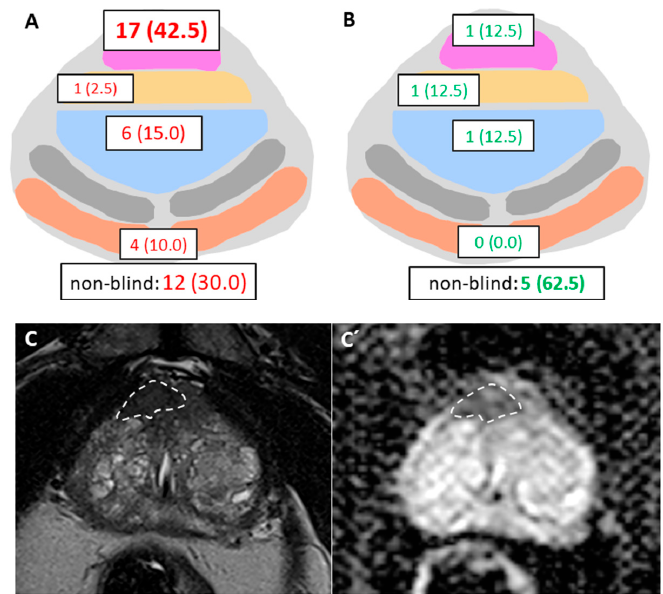
Figure 2. ( A , B ) Lesion-based visualization of prostate cancer that was missed or underestimated by systematic biopsy according to Ginsburg scheme in a representative axial plane with all four blind sectors (anterior region in pink, central transition zone in blue, basoventral sector yellow and basodorsal sector orange). ( A ) Localization of sPCa, with the majority localized in the anterior region. ( B ) Localization of nsPCa with the majority localized within a non-blind sector. ( C , C’ ) MRI with a 15 × 8 mm suspicious lesion in the anterior region with hypointense signal in T2 ( C ) and with a markedly low ADC ( C’ ) value. Targeted biopsy diagnosed sPCa (Gleason 6, cancer core length 11 mm). Table 3. Univariate and multivariate logistic regression analysis for missing sPCa within any blind sector ( A ) and specifically within the anterior region ( B ). (A) Missing sPCa within Any Blind Sector (B) Missing sPCa in the Anterior Region